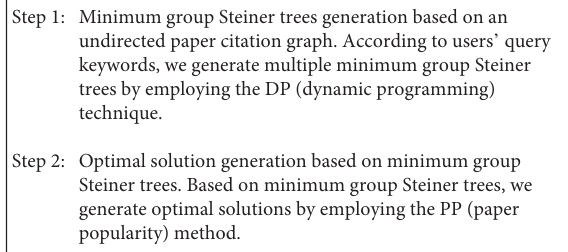
Figure 5: Concrete process of PR